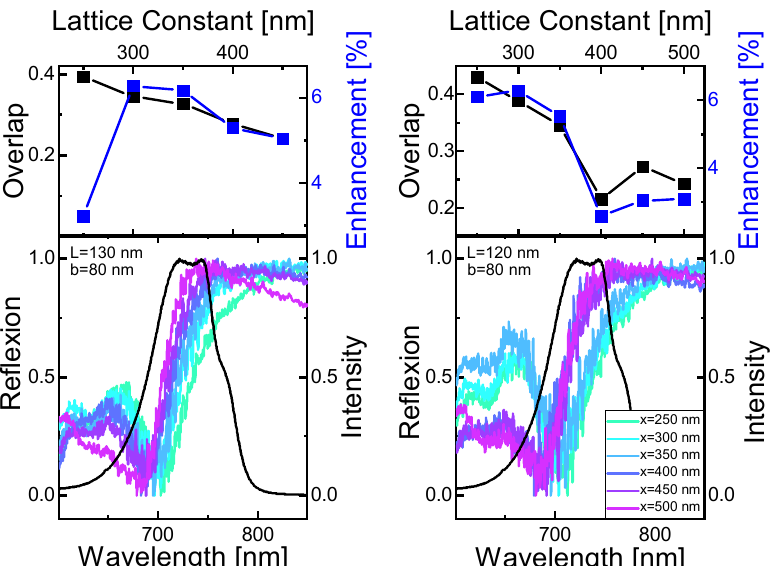
Figure 5. The experimental results for two antenna arrays are shown. In the lower part is the photoluminescence signal of the nanocrystals and the FTIR results depending on the lattice constant. The overlap decreases towards larger lattice constants. Accordingly, the gain shows a similar behavior. Except for one measurement point, the gain also decreases for larger lattice